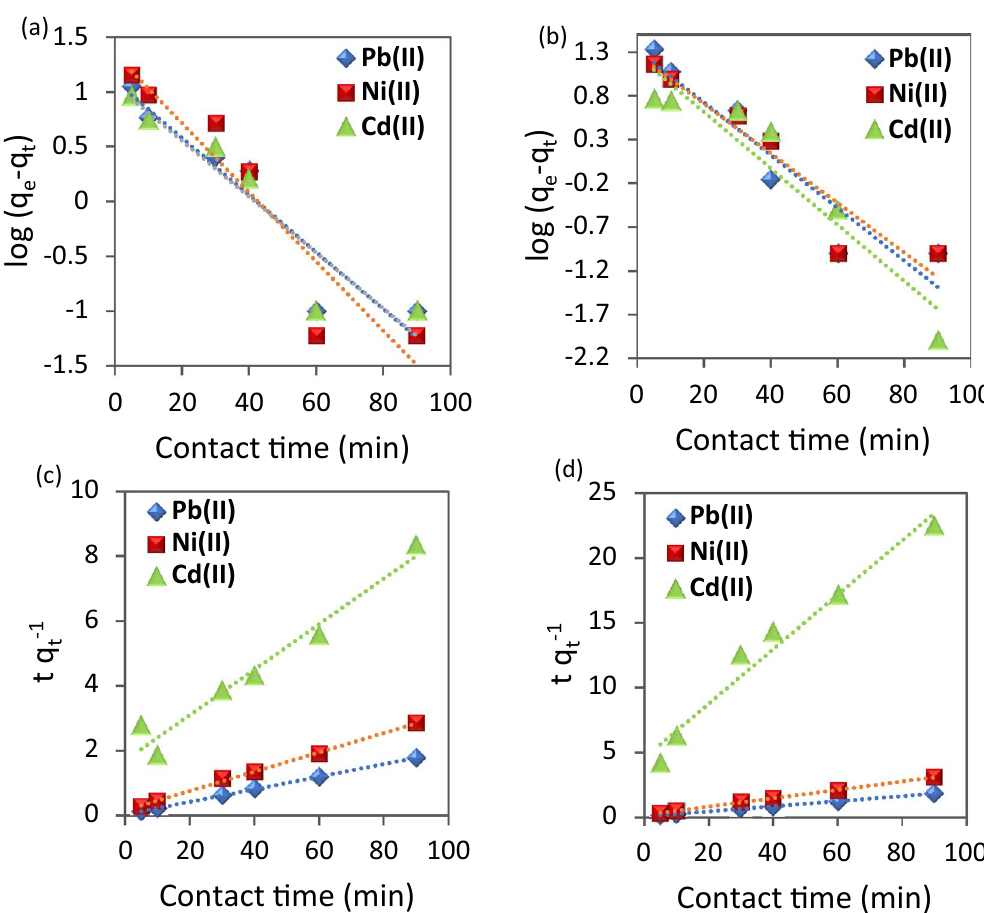
Figure 10. ( a,b ) Pseudo-first order and ( c,d ) Pseudo-second order for the adsorption metal ions using ( a,c ) CuO NPs-1 and ( b,d ) CuO NPs-2 at initial concentration: 20 mg L −1 , dose: 0.01 g, and pH